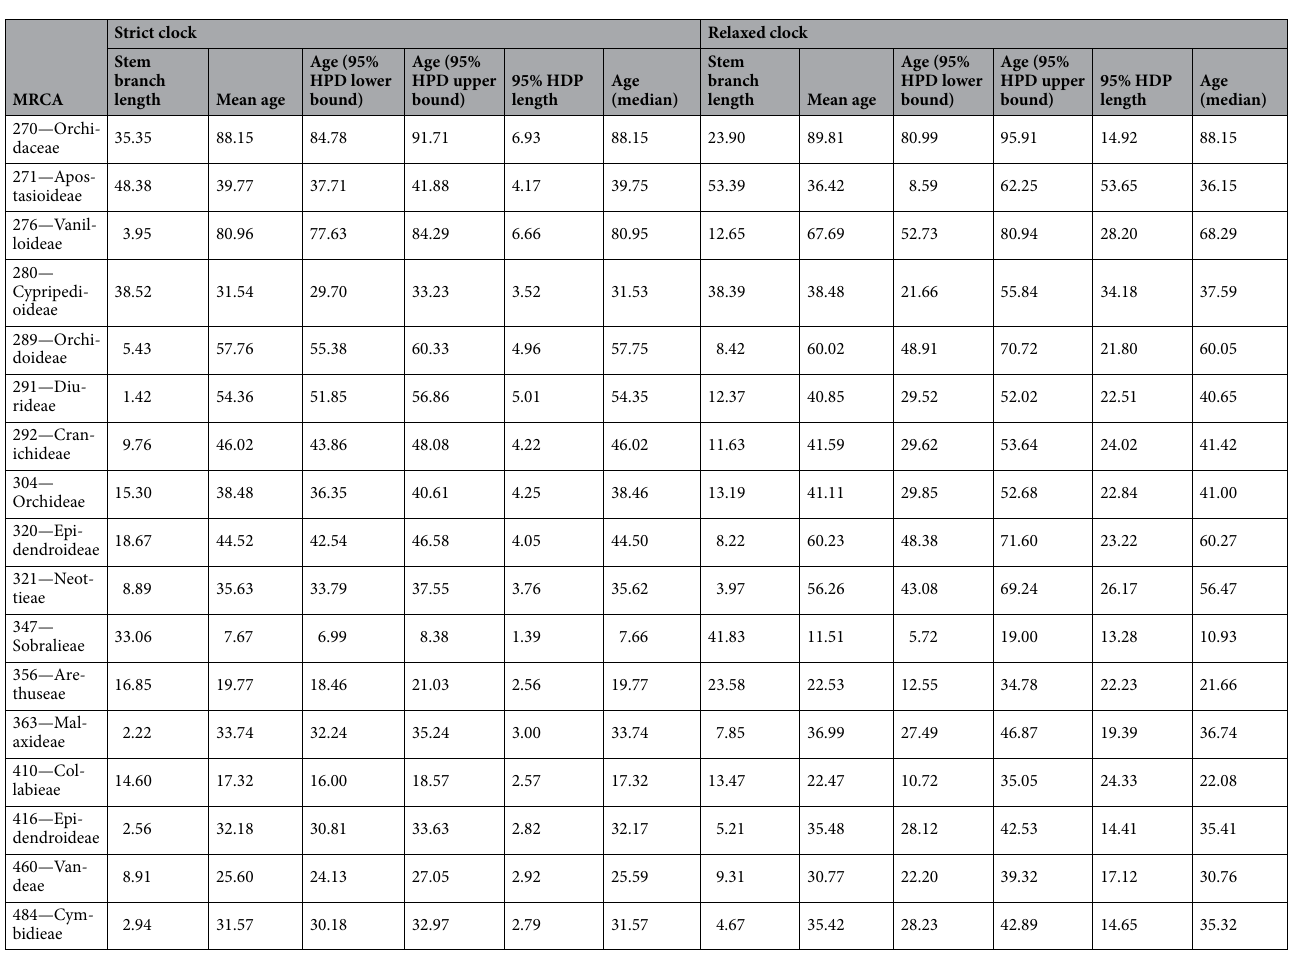
Table 1. Absolute age estimations of main orchid lineages under strict and relaxed clock